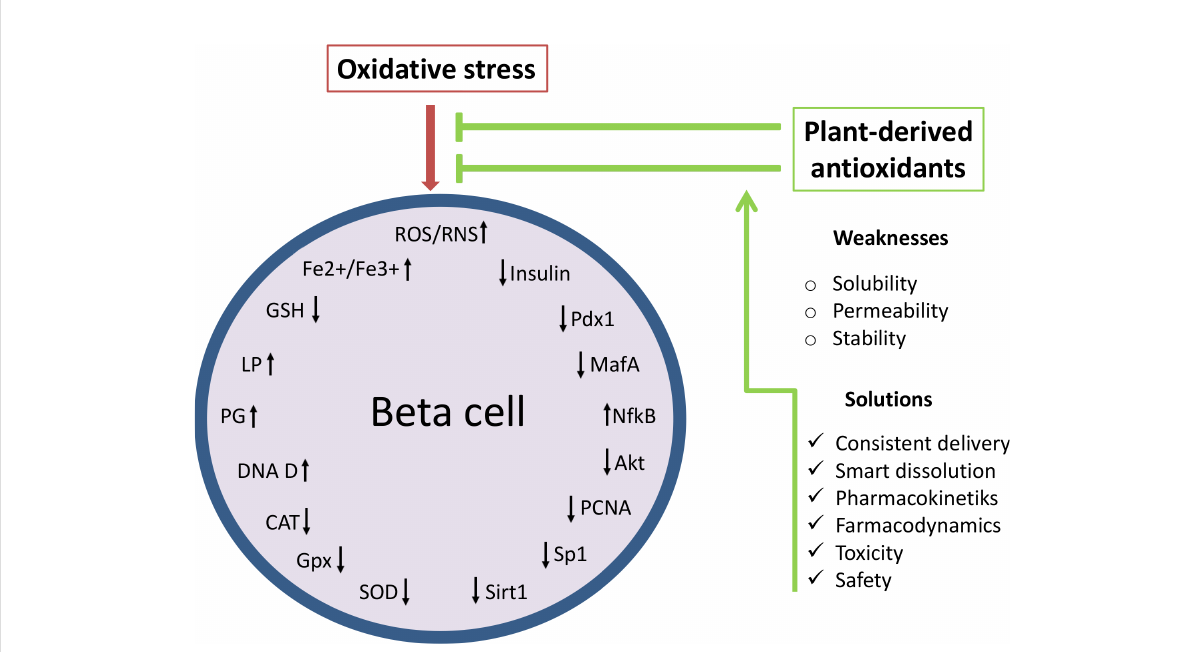
FIGURE 3 Effects of natural antioxidants (polyphenolic compounds) on oxidative stress-related targets: ROS production, redox modi fi cations and ROS- induced injury of beta cells. Oxidative stress reduces the functioning and survival of beta cells through oxidative damage and modi fi cations of macromolecules, disruption of the antioxidant defense system and reduction of beta cell maturity genes. Thus control of oxidative stress by plant-derived preparations has a great potential in the treatment of diabetes. However, the protective effect of natural antioxidants on beta cells can be enhanced by the improvement of a current antioxidant delivery approaches. ROS/ROS, reactive oxygen and nitrogen species; Fe 2+ /Fe 3+ , ferrous ions; LP, lipid peroxidation; PG, protein glycosylation; DNA D, DNA damage; SOD, superoxide dismutase; CAT, catalase; GPx, glutathione peroxidase; GSH, glutathione; NF-kB, nuclear factor kappa B; Akt, protein kinase B; Pdx1, duodenal homeobox factor-1; MafA, musculoaponeurotic fi brosarcoma oncogene homolog A; PCNA, proliferating cell nuclear antigen; Sp1, speci fi city protein 1; Sirt1, Silent information regulator